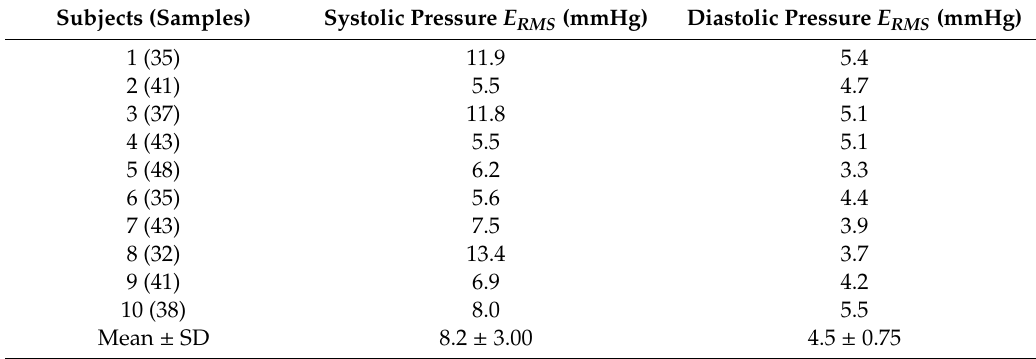
Figure 4. The correlation coefficient between pulse wave parameters and the blood pressure, ( a ) the systolic pressure, ( b ) the diastolic pressure. Table 4. The E RMS statistics (mean ± SD) of the estimated blood pressure for ten subjects using only the pulse transit time (PTT) parameter.